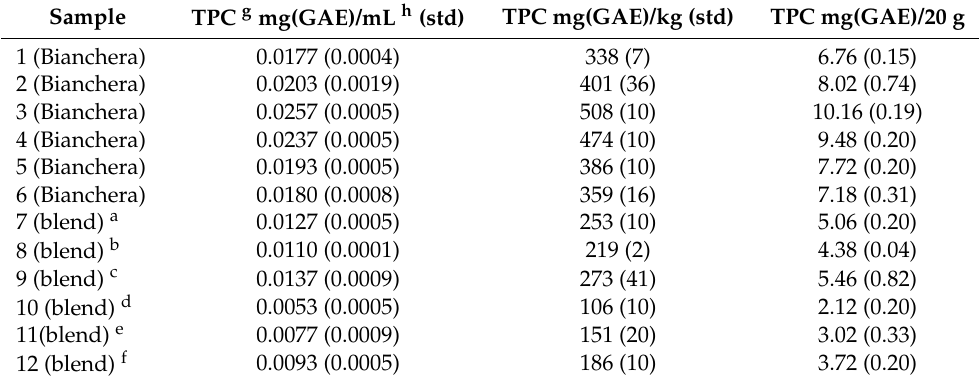
Table 6. Total phenolic content (TPC) of olive